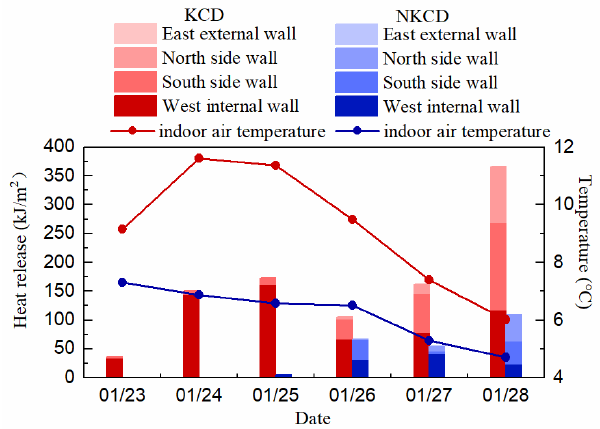
Figure 18. Heat release of walls during the night.